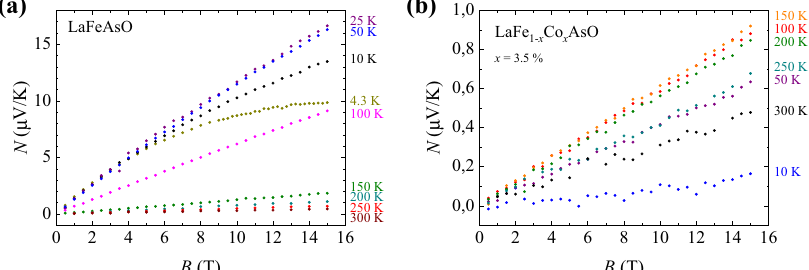
Fig. 8 Example of measured Nernst signal. Nernst signal as a function of magnetic fi eld B for LaFe 1 − x Co x AsO with ( a ) x = 0 and ( b ) x = 3.5% at different constant